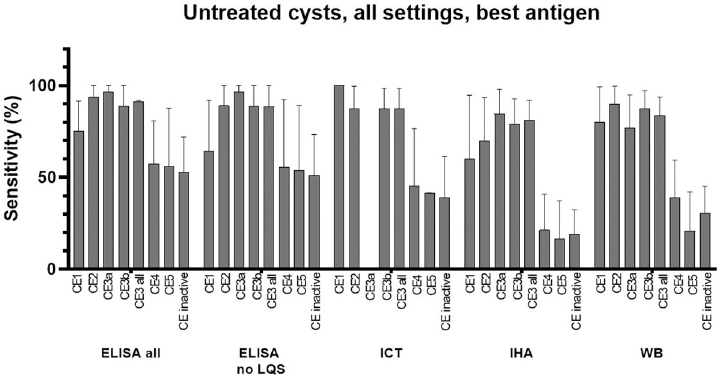
Fig 2. Sensitivity (%) of different serology tests for the diagnosis of untreated hepatic CE cysts according to cyst stage. “CE3 all” = data from CE3a + CE3b + CE3 not divided into CE3a and CE3b. “CE inactive” = data from CE4 + CE5 + CE4 and CE5 not divided into CE4 and CE5. LQS = Low Quality Studies. Data from papers referringto the field or to the hospital/lab setting were included. In case more than one assay per type was investigated in the same paper (e.g. more than one ELISA test), the one with the best sensitivity was used for the meta-analysis. Error bars represent 95% CI.